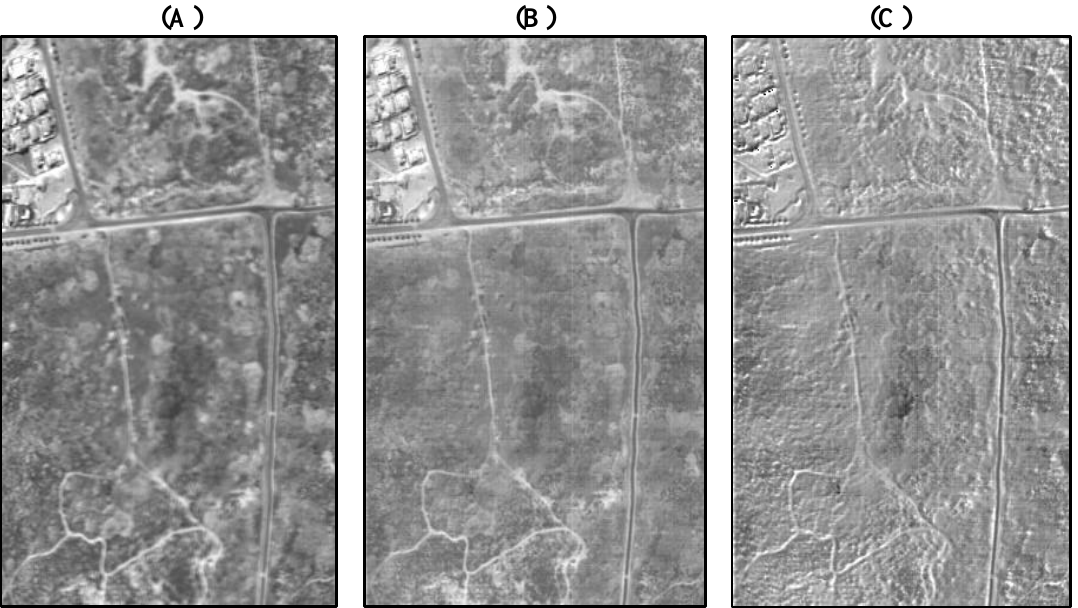
Figure 2. Additional boresight band (31 October 2009, 10:00 GMT, midlatitude summer model, 28.2° solar zenith, 137.6° azimuth angle): (A) the 948 nm band, (B) the 1,010 nm band, (C) calculated band ratio (920 nm/1,010 nm) interpreted as boresight